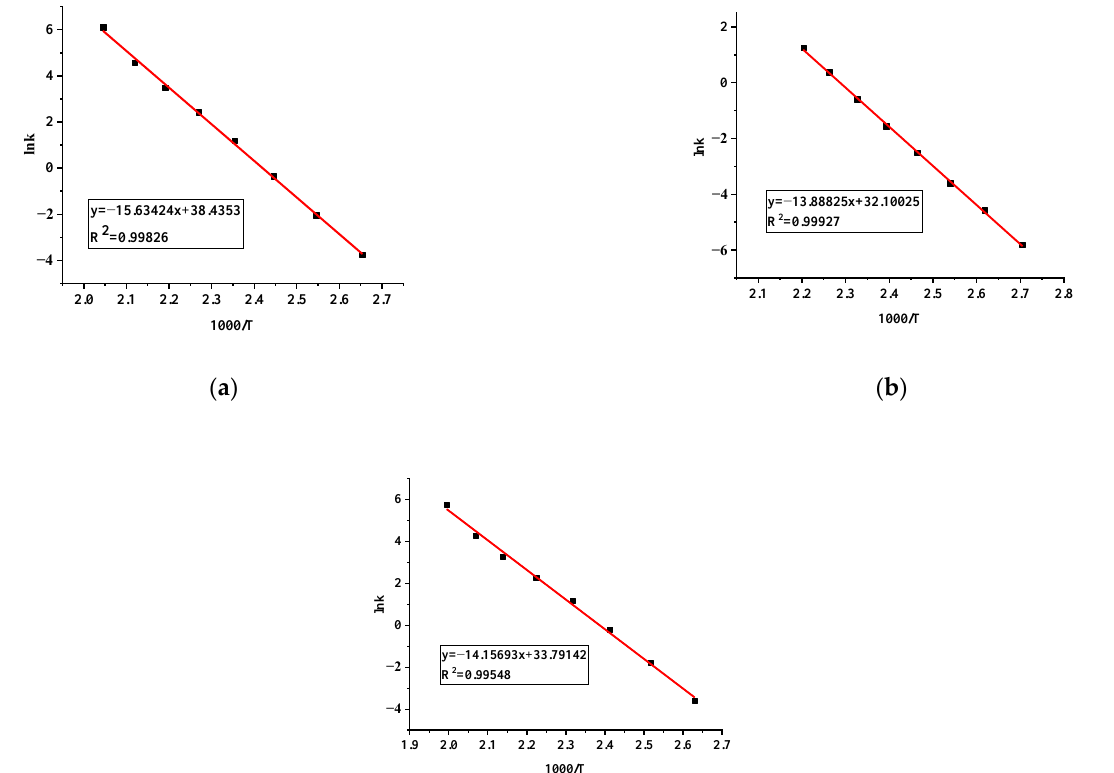
( c ) Figure 6. Adiabatic kinetic fitting results of pure TBPTMH ( a ) and mixtures with H 2 SO 4 and NaOH ( b , c